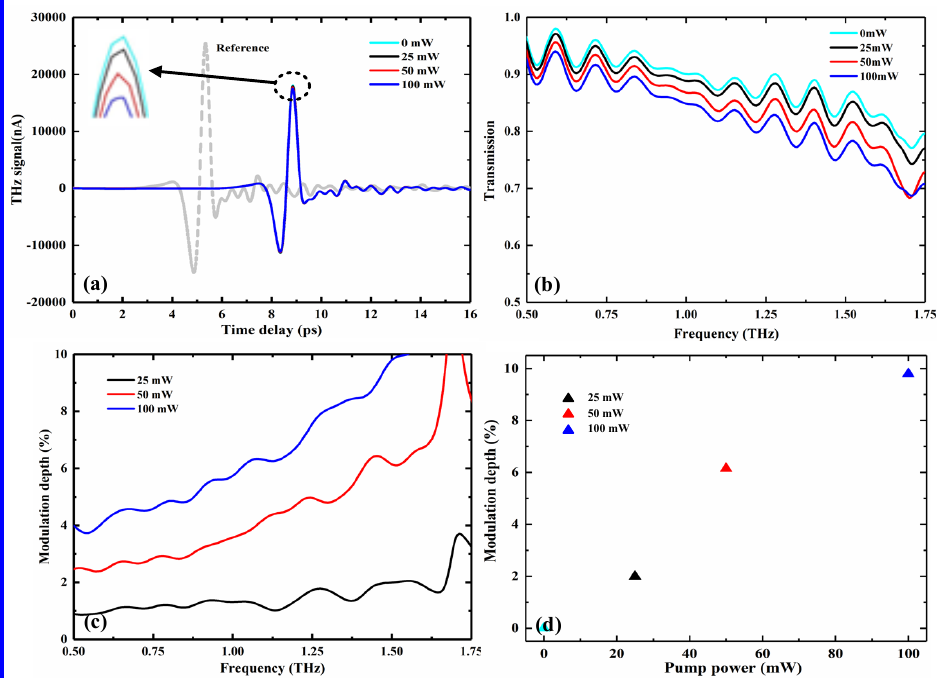
Figure 5. Terahertz performances of the fabricated (PEA) 2 (MA) 2 Pb 3 I 10 perovskite films at different irradiation powers of 25 mW, 50 mW, and 100 mW: ( a ) terahertz time − domain transmission spectra, in which the inset shows the magnification values at the peak, and the dashed line represents the time-domain transmission spectrum of the reference substrate without perovskite film; ( b ) terahertz frequency-domain transmission spectra; ( c ) modulation depth over the broadband range of 0.5–1.75 THz; and ( d ) modulation depth of different pump powers at 1.5 THz.